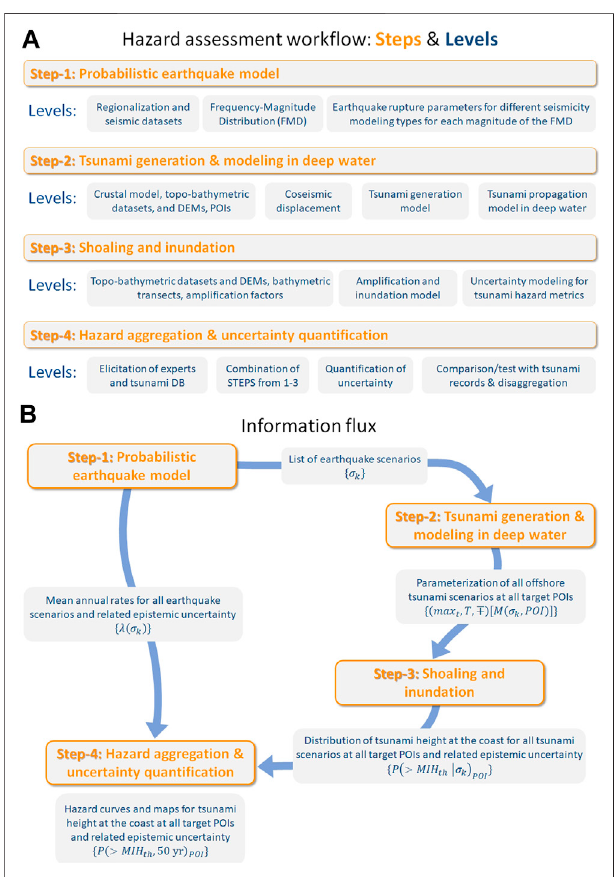
FIGURE 3 | (A) Sketch of the NEAMTHM18 work fl ow. (B) Sketch of the information fl uxtobuildthehazardmodel.Thisprocedureisrepeatedforeach considered alternative